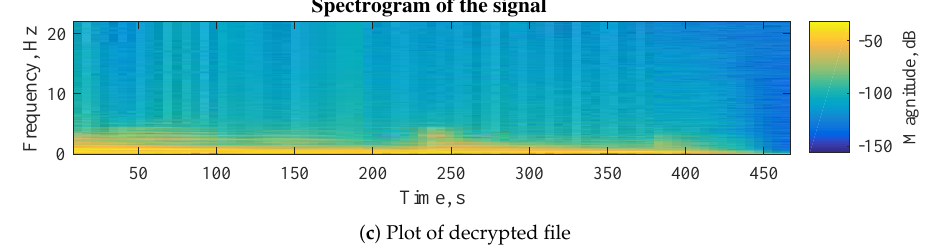
Figure 6. Spectrogram plotting.